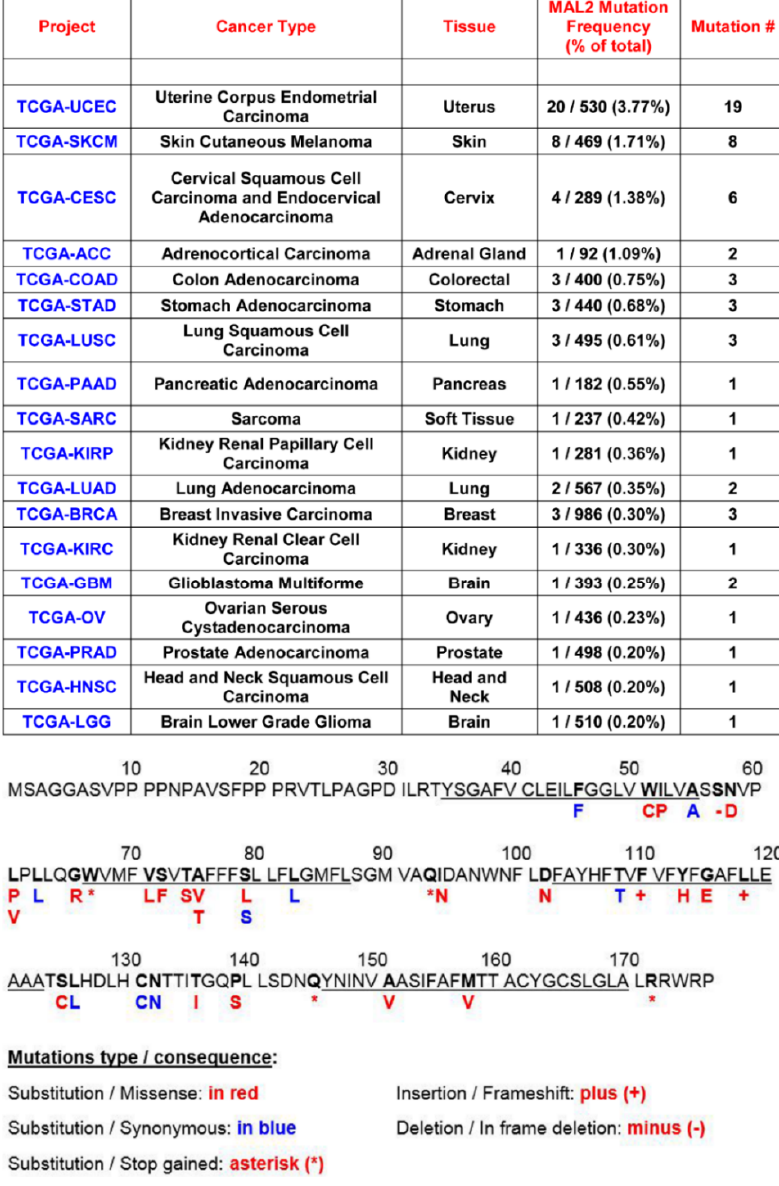
Figure 11. MAL2 has a low somatic mutation frequency in human cancers. MAL2 mutation rates for 18 di ff erent human cancer types were determined from data compiled by the NCI Genomic Data Commons. Below, the specific patient mutations (and consequences) in the MAL2 amino acid sequence are indicated in blue and red. MAL2 transmembrane domains are underlined.